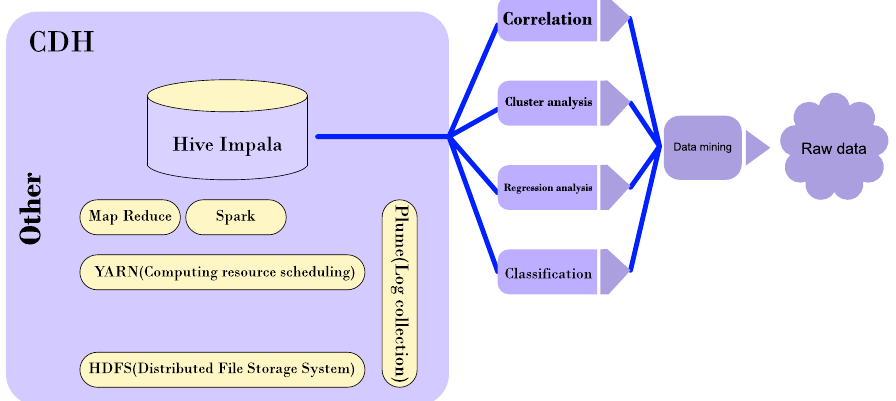
Figure 9. The process of acquiring raw